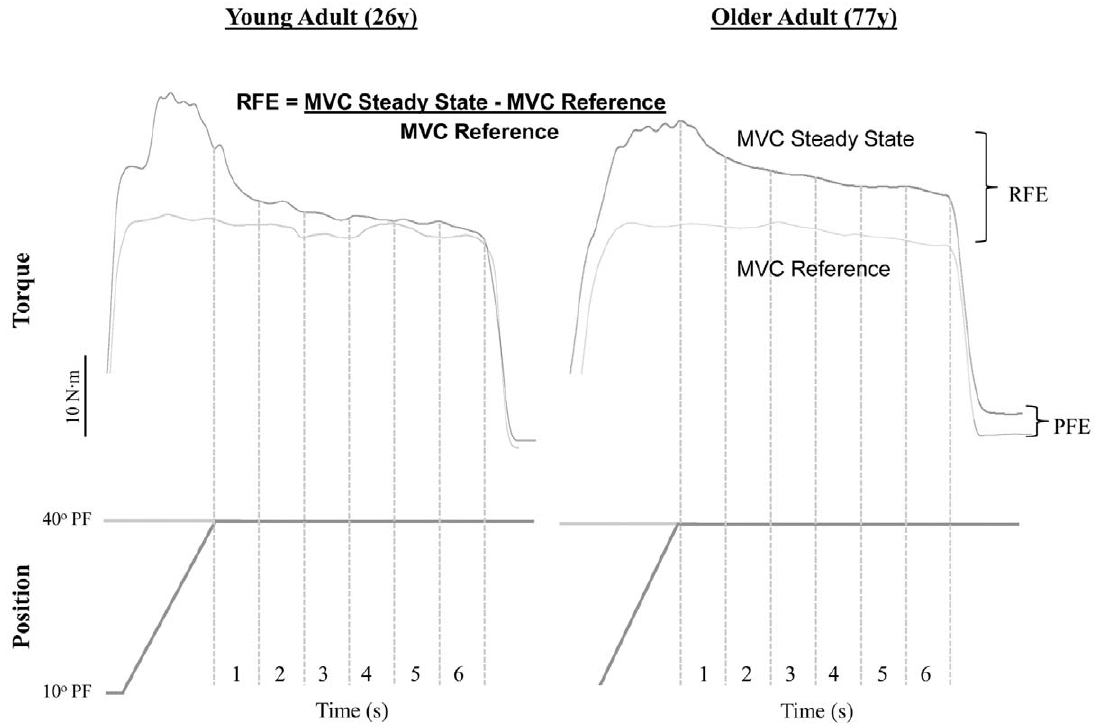
Figure 1. Raw data depicting the determination of residual force enhancement (RFE) in older and young men. Passive force enhancement (PFE) was determined as elevated force above rested baseline upon relaxation after stretch.